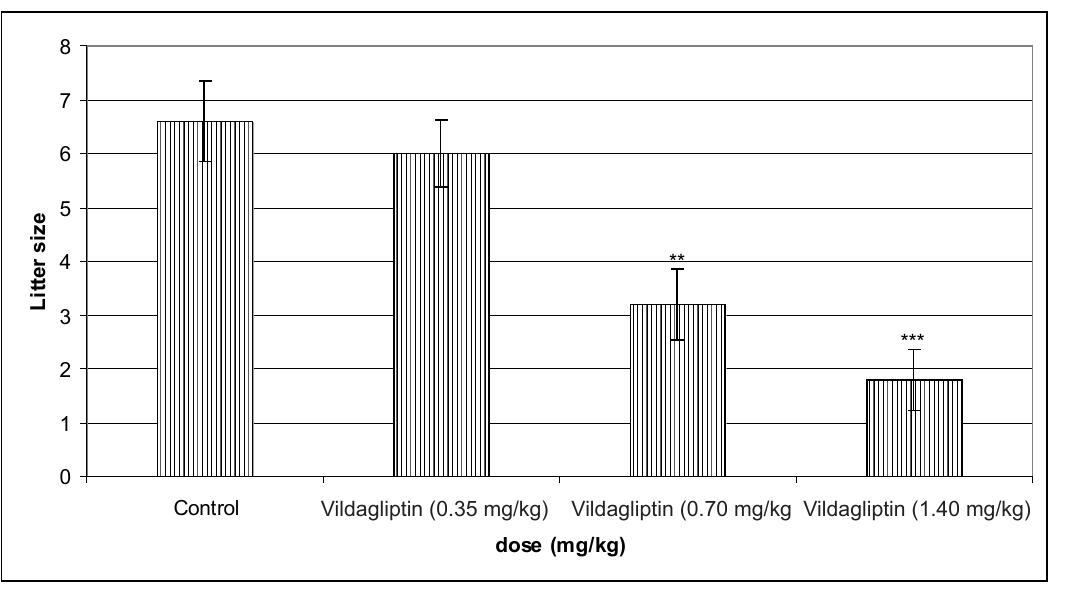
FIGURE 4 – Effects of vildagliptin on average litter size. ** = significantly different from control (p < 0.01). *** = significantly different from control (p <